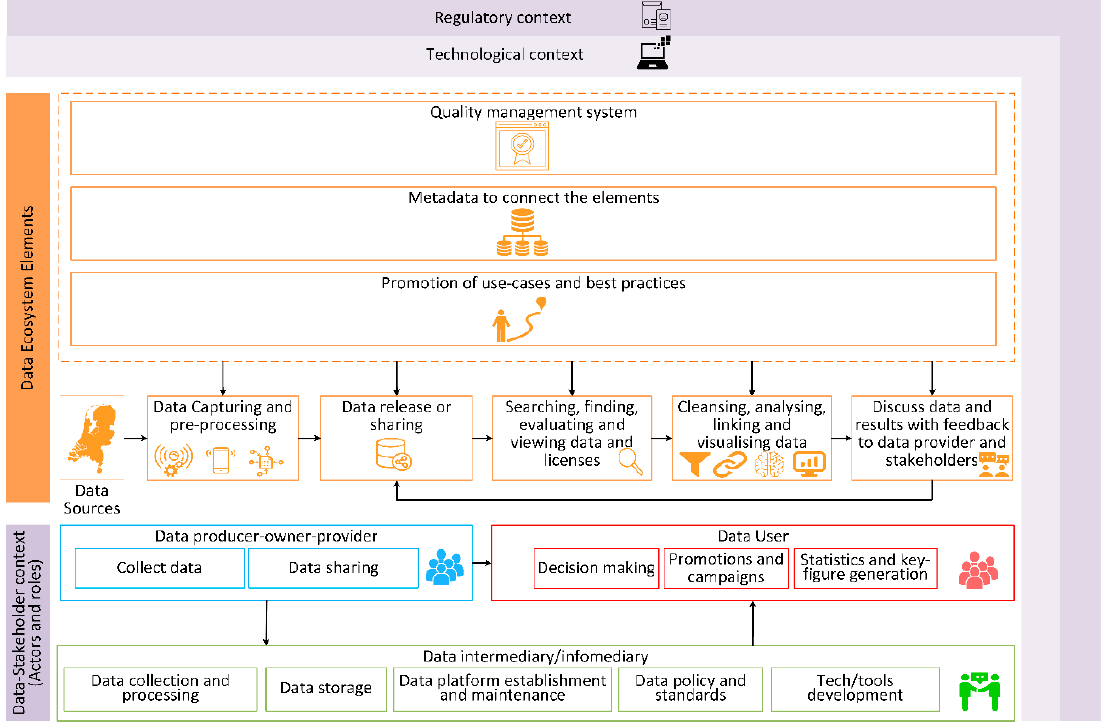
Figure 1. Framework for developing a data ecosystem.